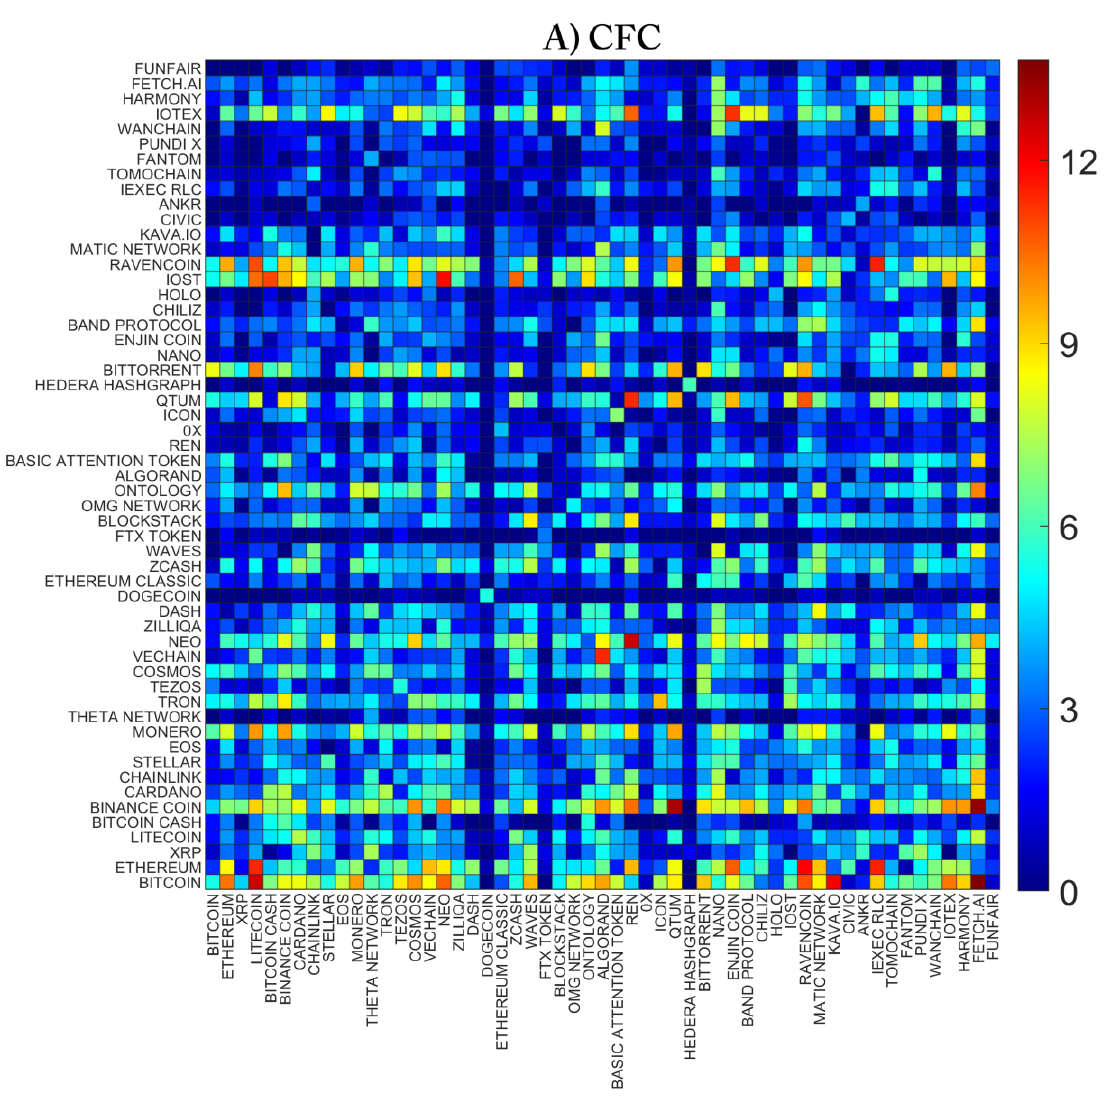
Fig. 4A. Total pair-wise cross-frequency coupling (CFC). Each pixel value corresponds to the sum of all significant CFC values for each pair of